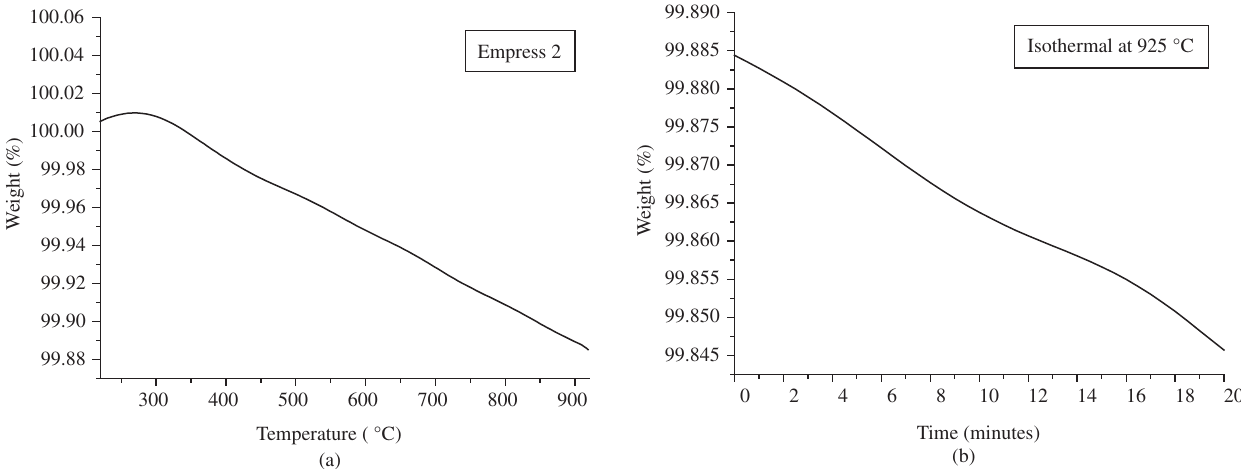
Figure 2. Thermal gravimetric analysis (TGA) curves for Empress 2: weight loss during heating stage up to a) 925 °C and under isothermal condition at b) 925